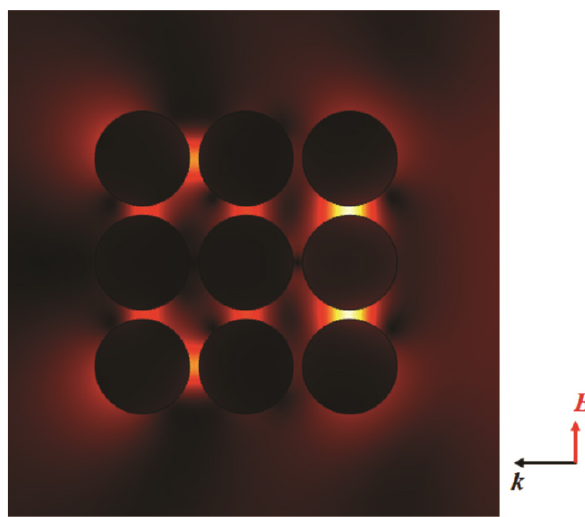
Figure 3: Electric field distribution ( | E | ) of Au nanorod arrays with a side incident Gaussian